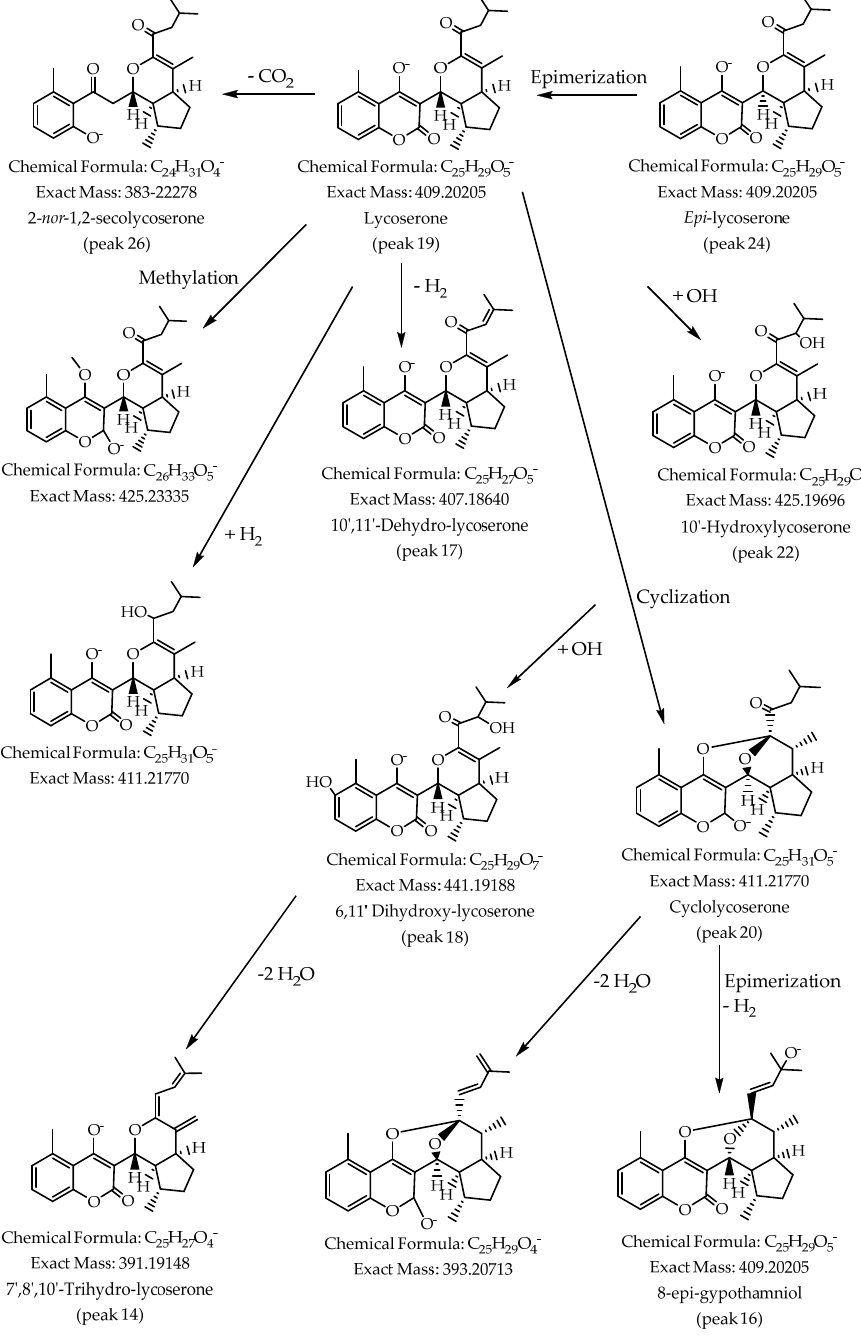
Figure 3. Proposed biosynthetic relationship between the coumarin derivatives detected in G. pinifolium.